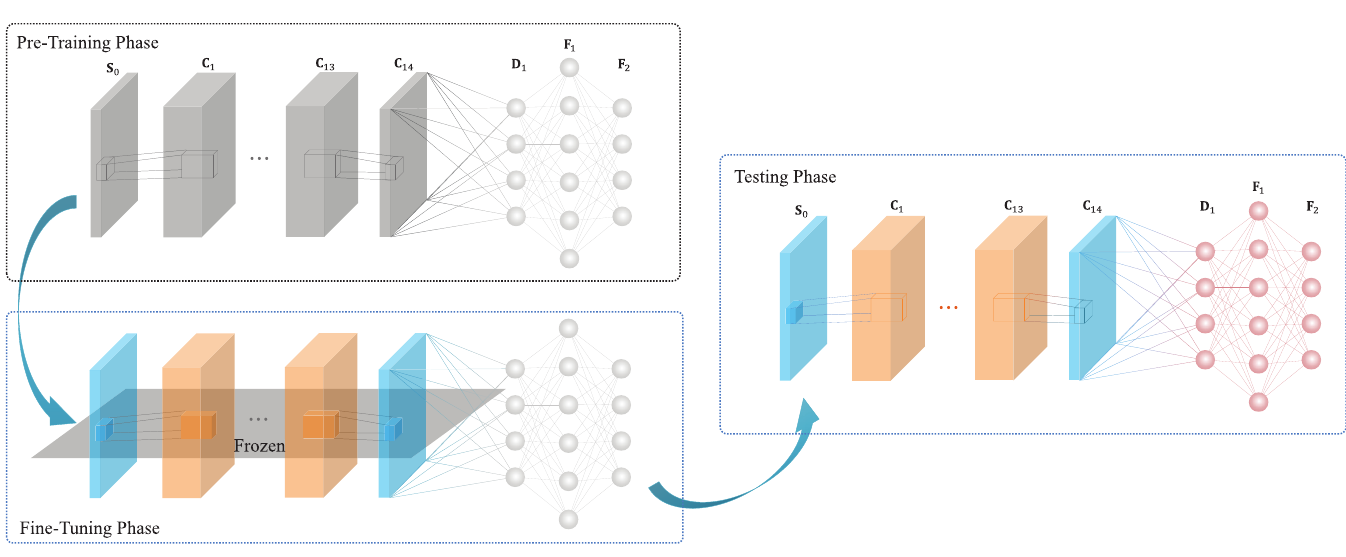
Fig 2. The proposed ReCNN-based TL scheme for model